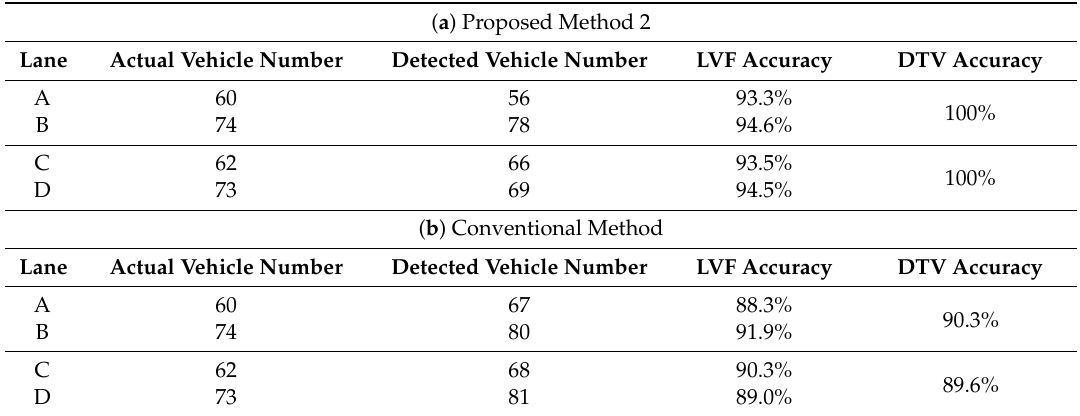
Table 7. Results of LVF and DTV detection during 12:00–12:10 PM (moderate traffic) using ( a ) proposed method 2 and ( b ) conventional method.